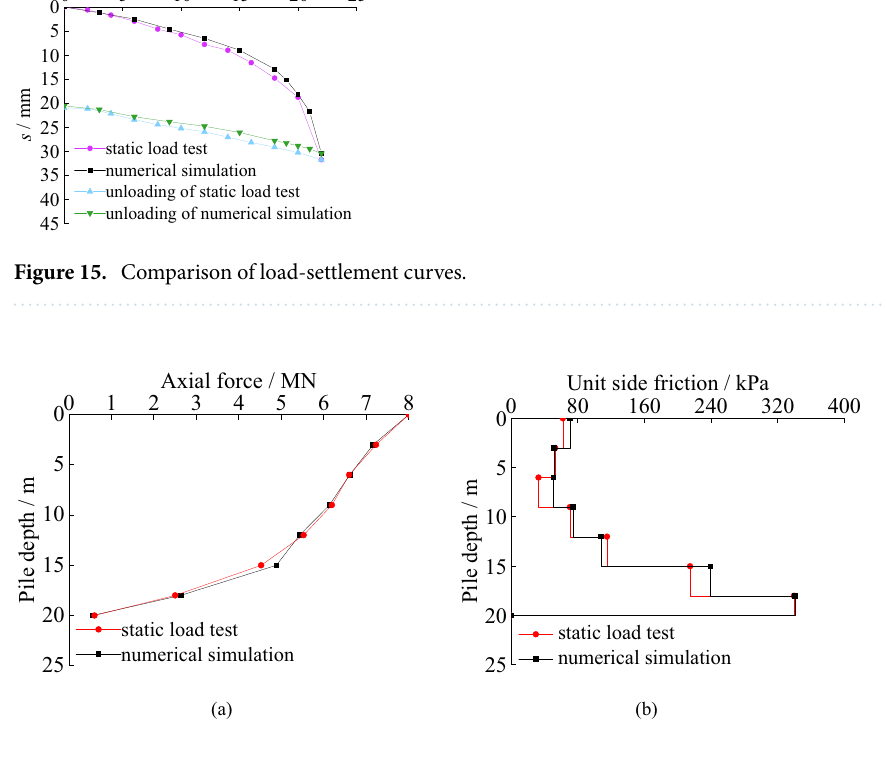
Figure 16. Load Transfer Law: ( a ) Comparison of axial force of piles; ( b ) Comparison of unit side friction of